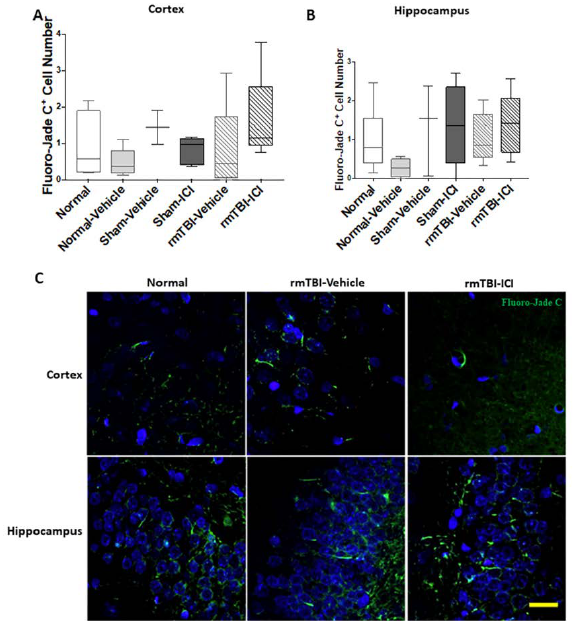
Figure 3. Neuronal degeneration in the brain of day 11 following mTBI on days 1 and 2. Fluoro-Jade C + cell numbers are shown as median, interquartile range, and range in the ( A ) cortex and the ( B ) hippocampus. ( C ) Representative images of Fluoro-Jade C staining indicating degenerating neurons; scale bar = 25 µ